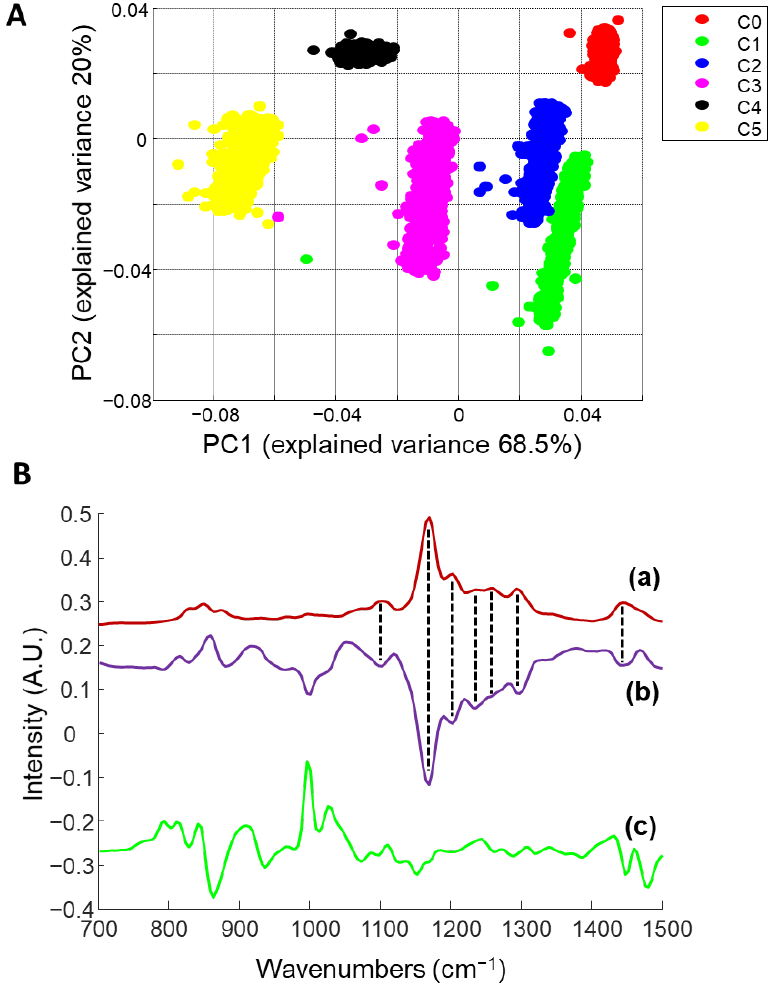
Figure 6. ( A ): Scatter plot from principal component analysis (PCA) performed on PVA-GS films with increasing NanoPHE concentrations ( C0 : red, C1 : green, C2 : blue, C3 : pink, C4 : black, and C5 : yellow). ( B ): Loading 1 ( b ) and Loading 2 ( c ) of the PCA ( b ) compared to the reference spectra of NanoPHE ( a ). Spectra are offset for clarity.